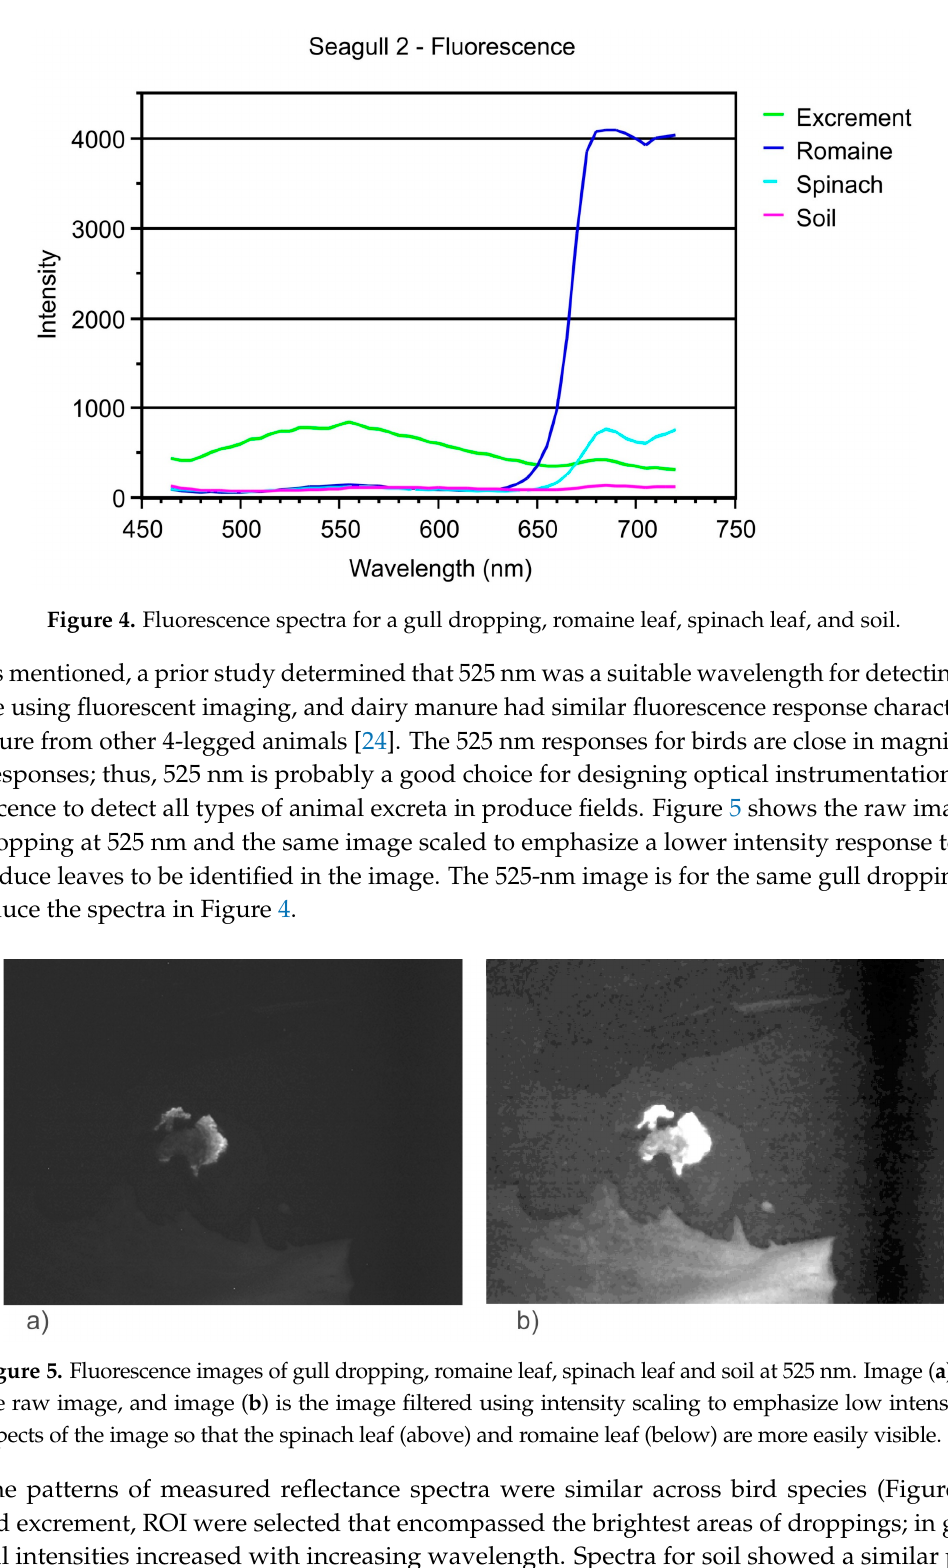
Figure 3. Fluorescence spectra for a pigeon dropping, romaine leaf, spinach leaf, and soil. Note that data from the image at 465 nm were excluded as the image was found to have been corrupted.